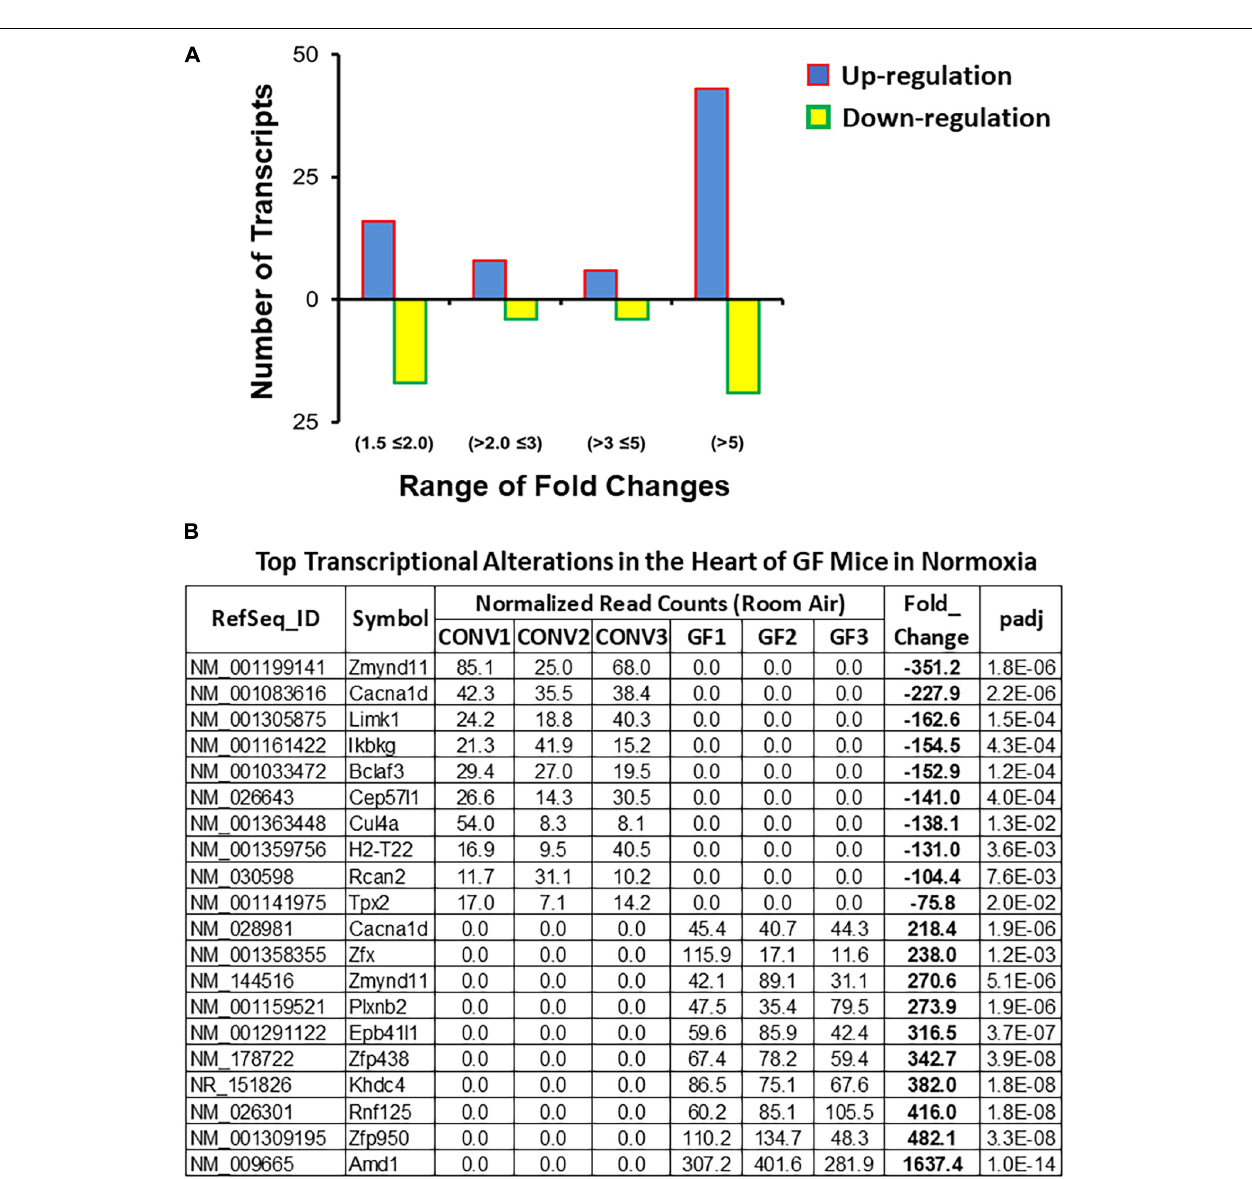
FIGURE 2 | Summary of transcriptome alterations in the heart of GF mice under normoxic condition. (A) Distribution of fold change of the 117 differentially expressed genes (DEGs) (| Fold change| > 1.5 and Benjamini–Hochberg adjusted p < 0.05) in the left ventricle of GF mice as compared to CONV controls ( Supplementary Table 2 ). (B) List of top 10 significantly up- or downregulated